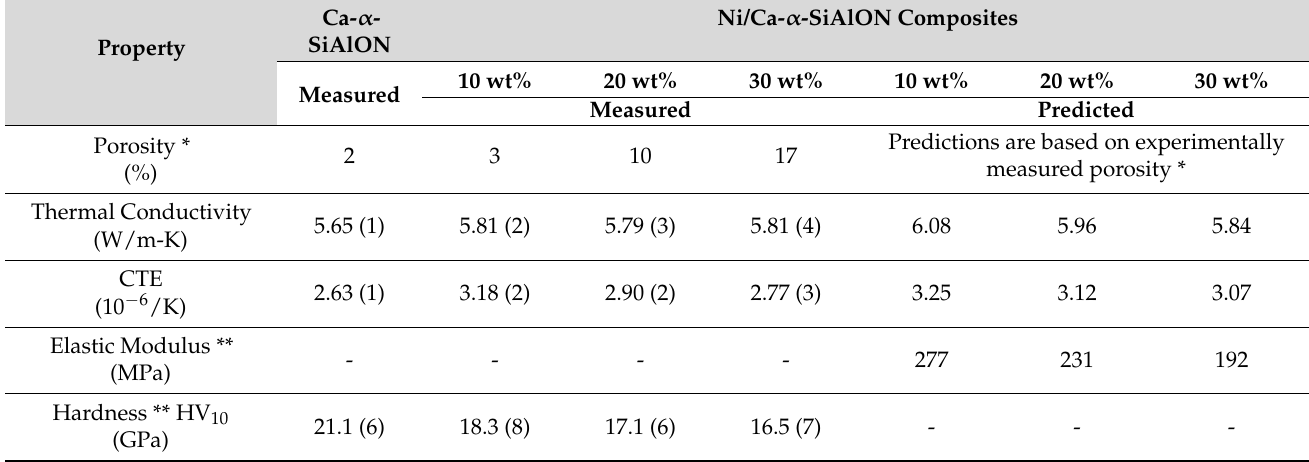
Table 3. A comparative analysis of computational prediction and experimentally measured ther- momechanical properties of Ni-reinforced Ca/ α -SiAlON composites. ** The hardness of composite tends to increase with an increase in the elastic modulus as predicted. * Experimentally measured porosity from actual